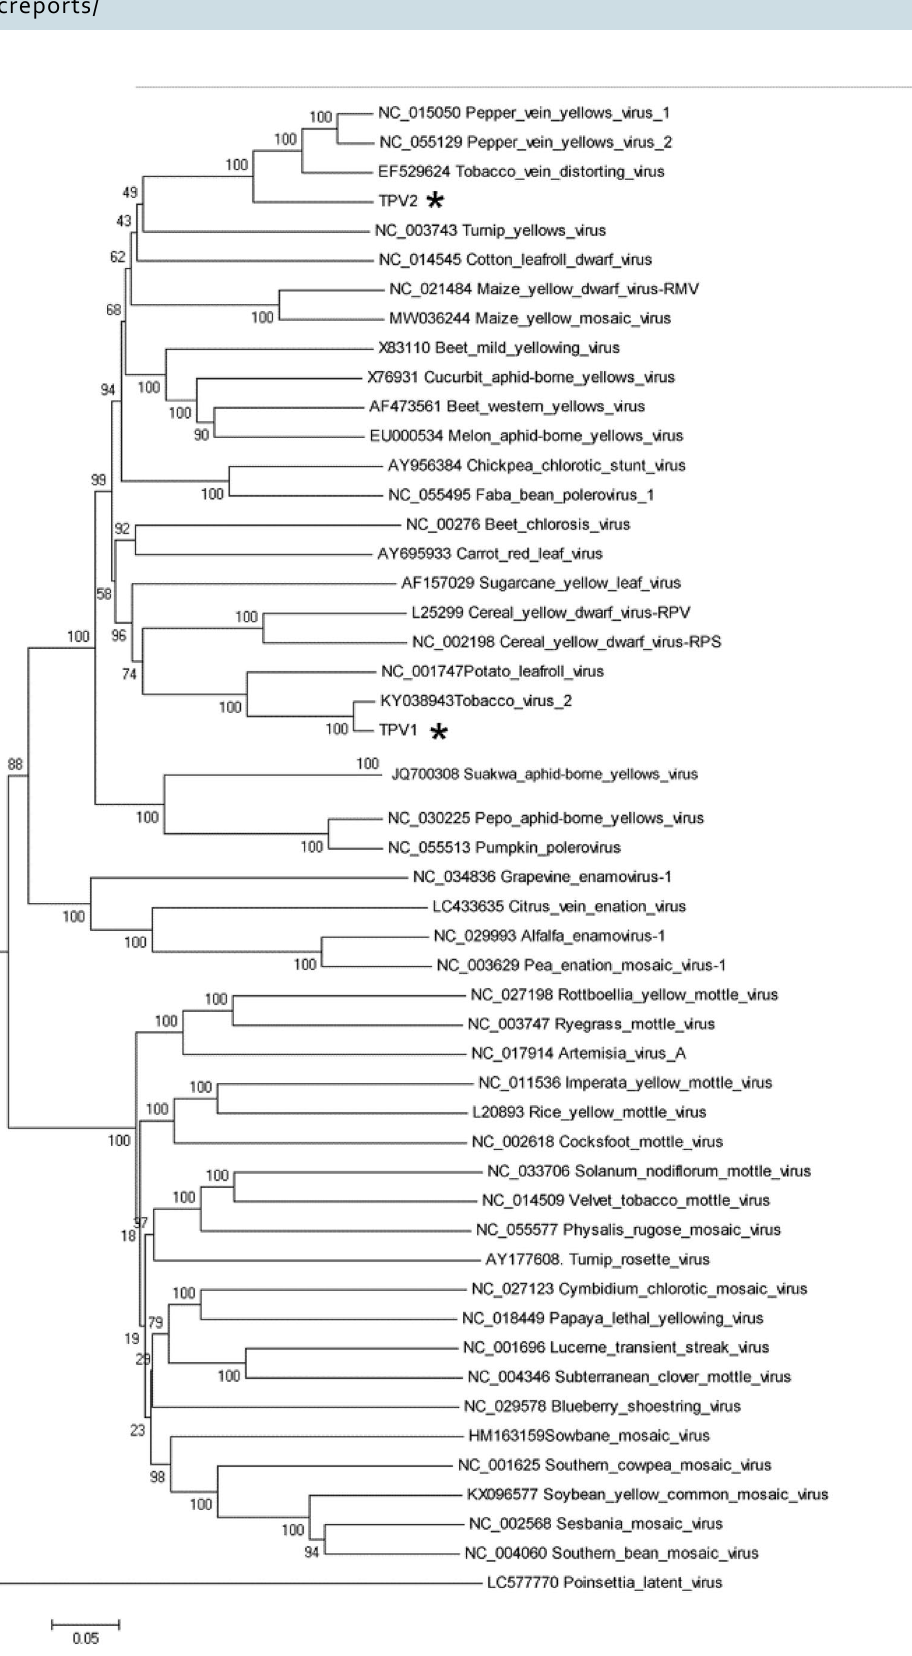
Figure 3. Neighbor joining tree (NJ) of the RdRp nt sequences of TPV1, TPV2 as well as those of other viruses in the family Solemoviridae. The phylogenetic trees are based on alignments of the nt sequences. The sequences were aligned with Clustal W and NJ trees constructed with MEGA 5.0. The scale bar indicates the genetic distance. *Two novel